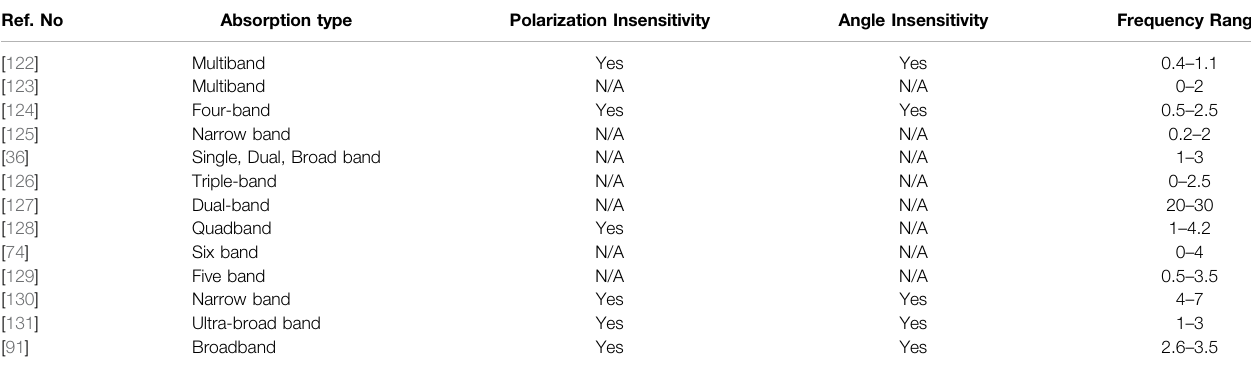
TABLE 3 | M etamaterial absorbers in terahertz